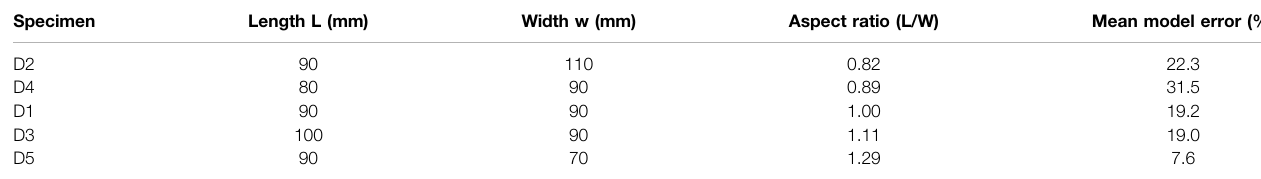
TABLE 3 | PRA parameters. STAR PRA Wedge PRA L = 138 mm L = 138 mm w = 100 mm w = 100 mm Aspect Ratio L/w = 1.38